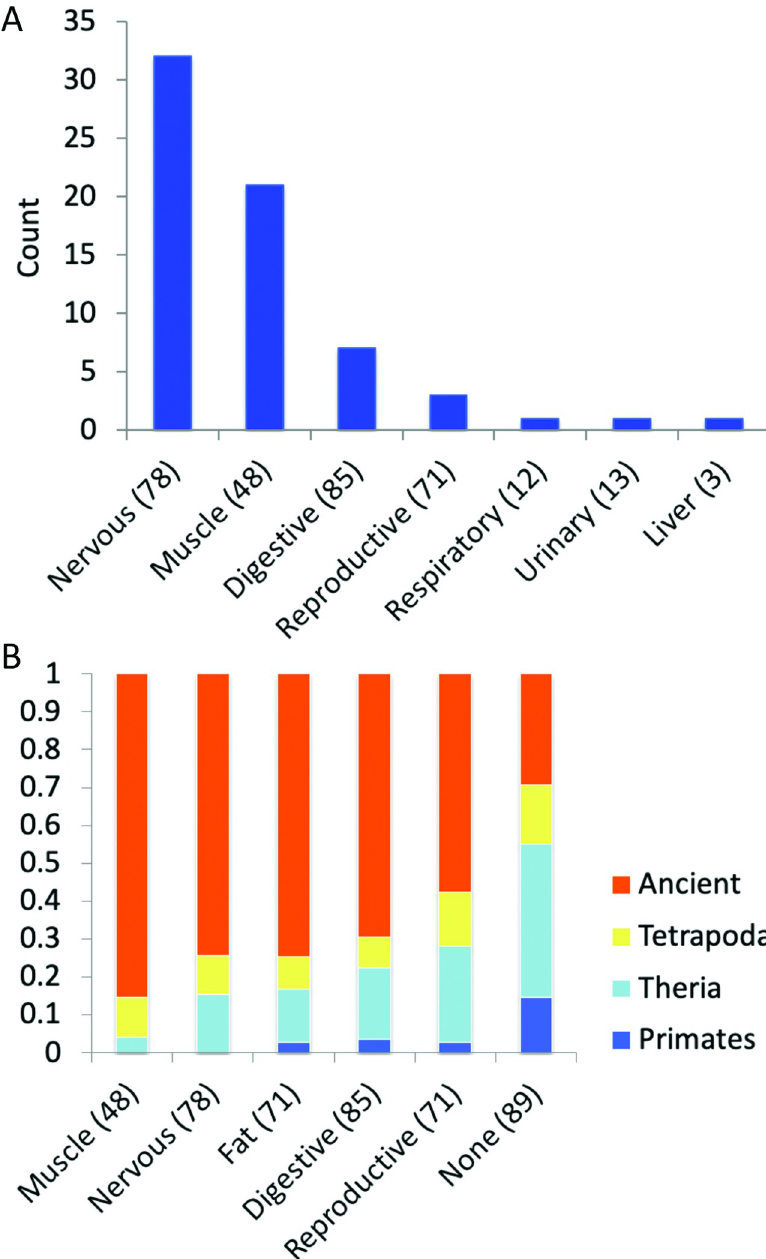
Fig 5. Comparison of RNA-level tissue-specific events. (A) The number of transcript-level enriched events also enriched at the protein level. Each bar shows the number of transcript-level tissue group enriched events that are enriched in the same tissue group in proteomics experiments. Enriched events were compared over the 9 tissue groups that coincided in both transcriptomics and proteomics experiments. The number of events that were tissue-specific in the transcriptomics experiments for each group is shown in brackets. (B) The age of the events enriched in RNAseq studies in the five most populated tissue groups and those not enriched at all (None). At the RNAseq level more of the muscle and nervous tissue enriched events are ancient than those in any other tissue. Results shown for tissues with a minimum of 48 tissue-specific enriched events.